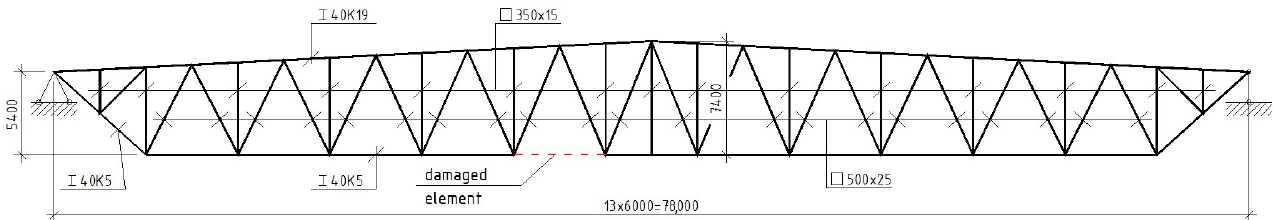
Figure 10. Truss with a span of 78 m and a damaged lower chord.